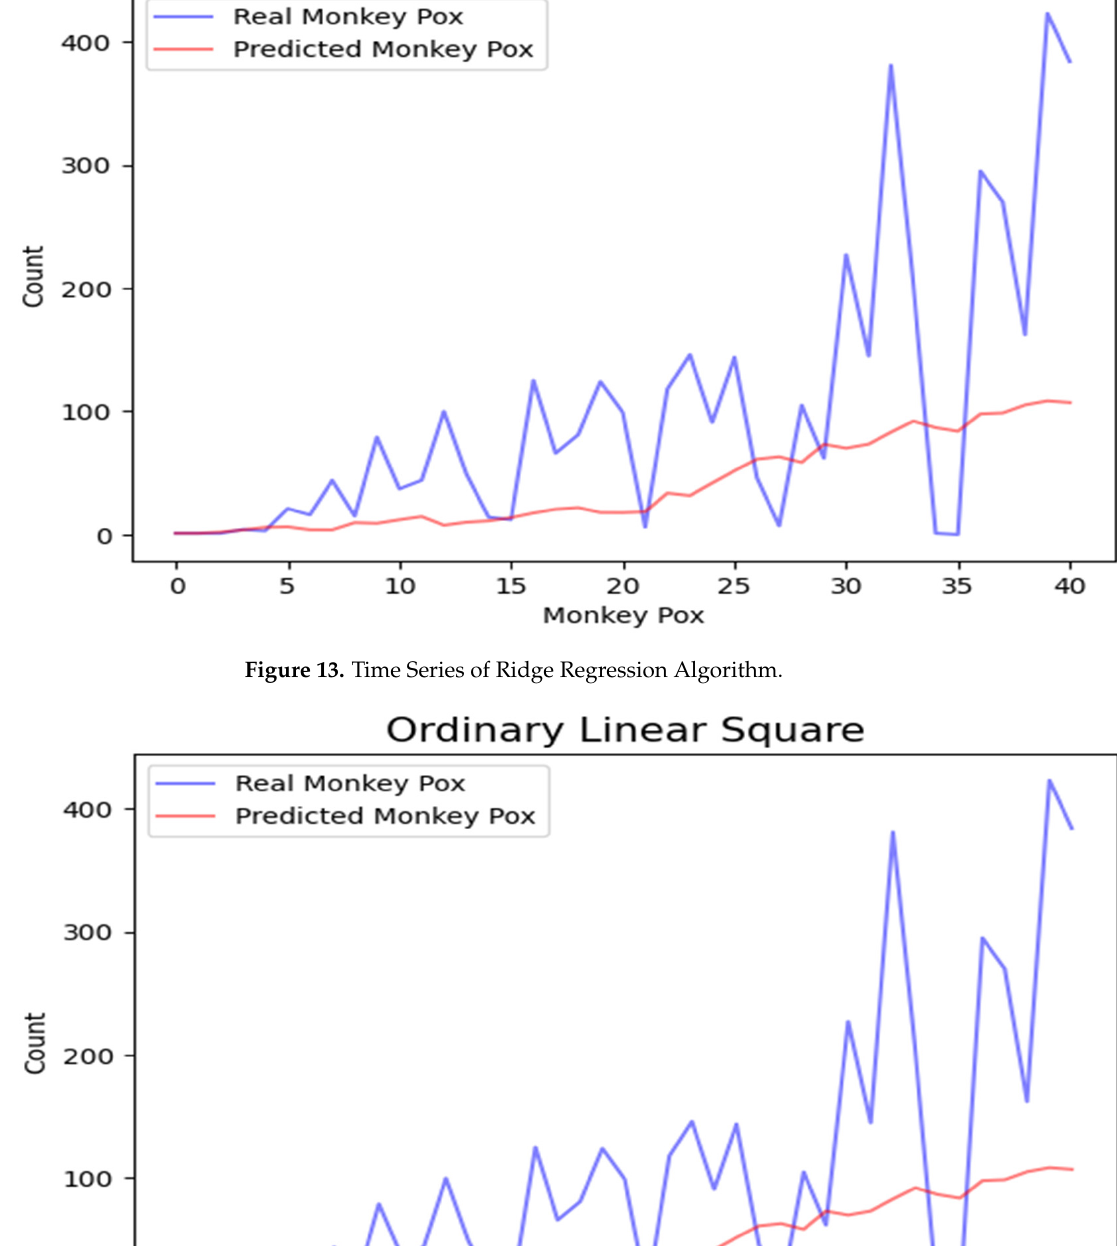
Figure 12. Time Series of Least Absolute Shrinkage and Selection Operator Algorithm.